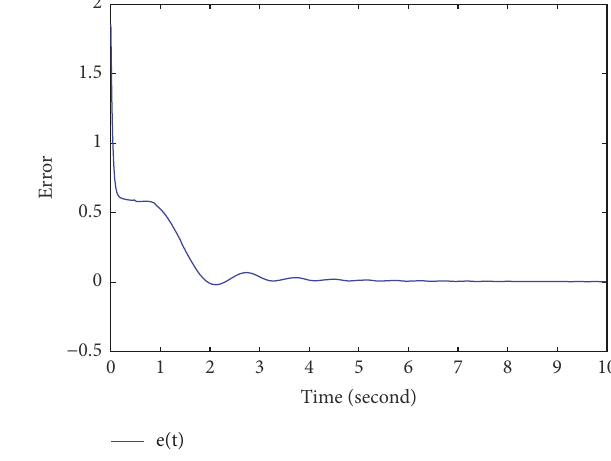
Figure 4: The trajectories of estimate error.